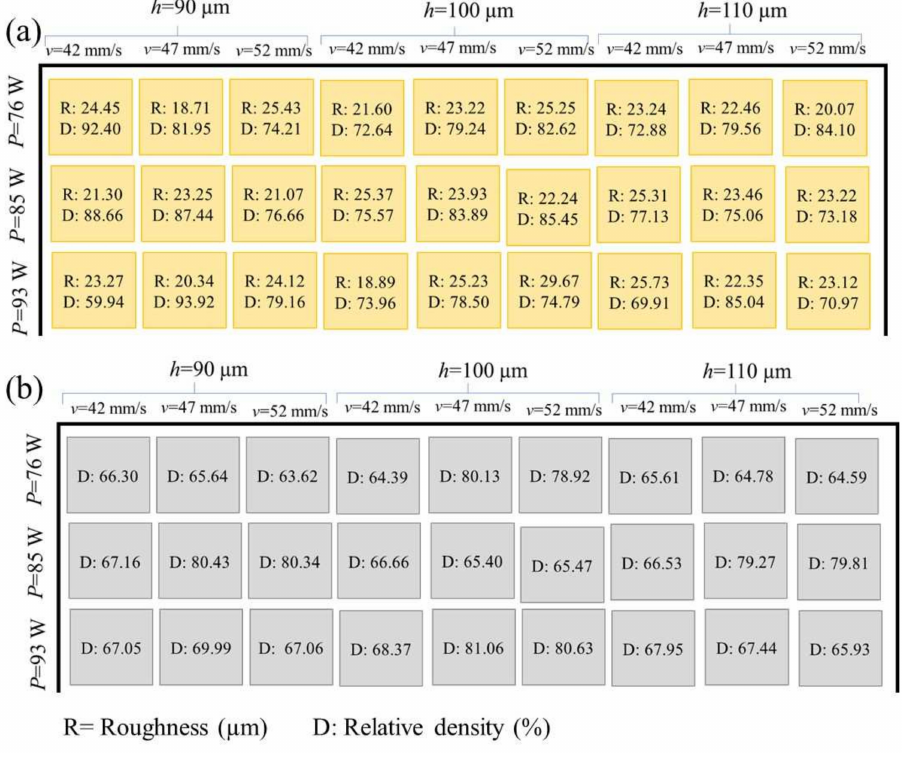
Figure 4. Relative density and roughness for LPBF-AM ( a ) Cu and ( b ) Cu-CNT samples correspond- ing to their building